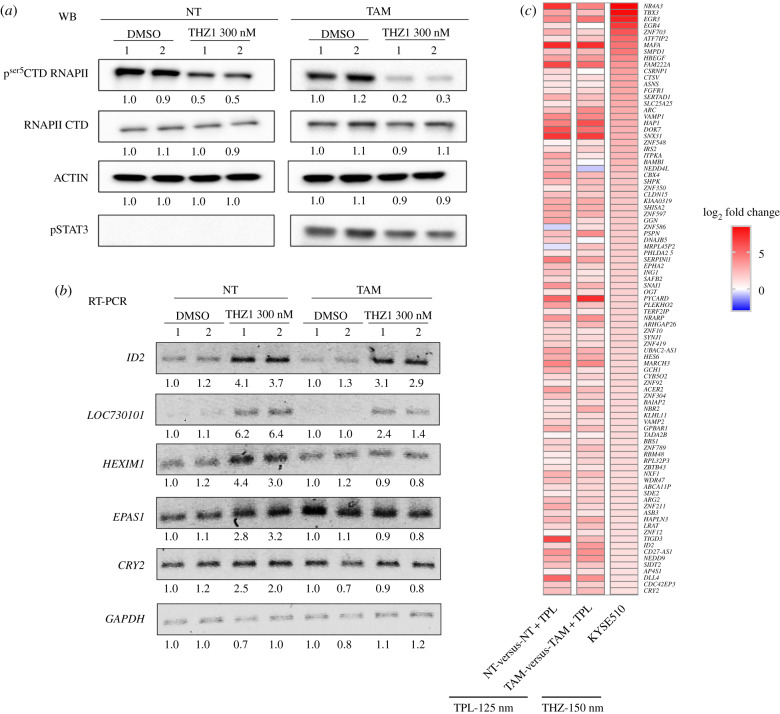
THZ1 generates a similar response as observed by the effect of TPL on transformed cells. (a) pSer5CTD RNAPII and RNAPII CTD levels in tamoxifen-treated (TAM) and non-treated (NT) cells treated with 300 nM of TPL for 2 h or with DMSO as control. STAT3 phosphorylated is an indicator of the transformed phenotype in TAM cells. (b) Semiquantitative RT-PCR of NT and TAM cells treated with 300 nM of THZ1 for 2 h of ID2, LOC730101, CRY2, EPAS1 and HEXIM1. Densitometric analyses (a) and (b) were performed using actin or GAPDH as a loading control in western blot and RT-PCR respectively; the relative quantification is indicated under each blot and the data showed represent at less two biological replicates. (c) Comparison with published data of the THZ1 response in KYSE510 cells [54] indicating a similar response to some of the overexpressed genes after TPL treatment.